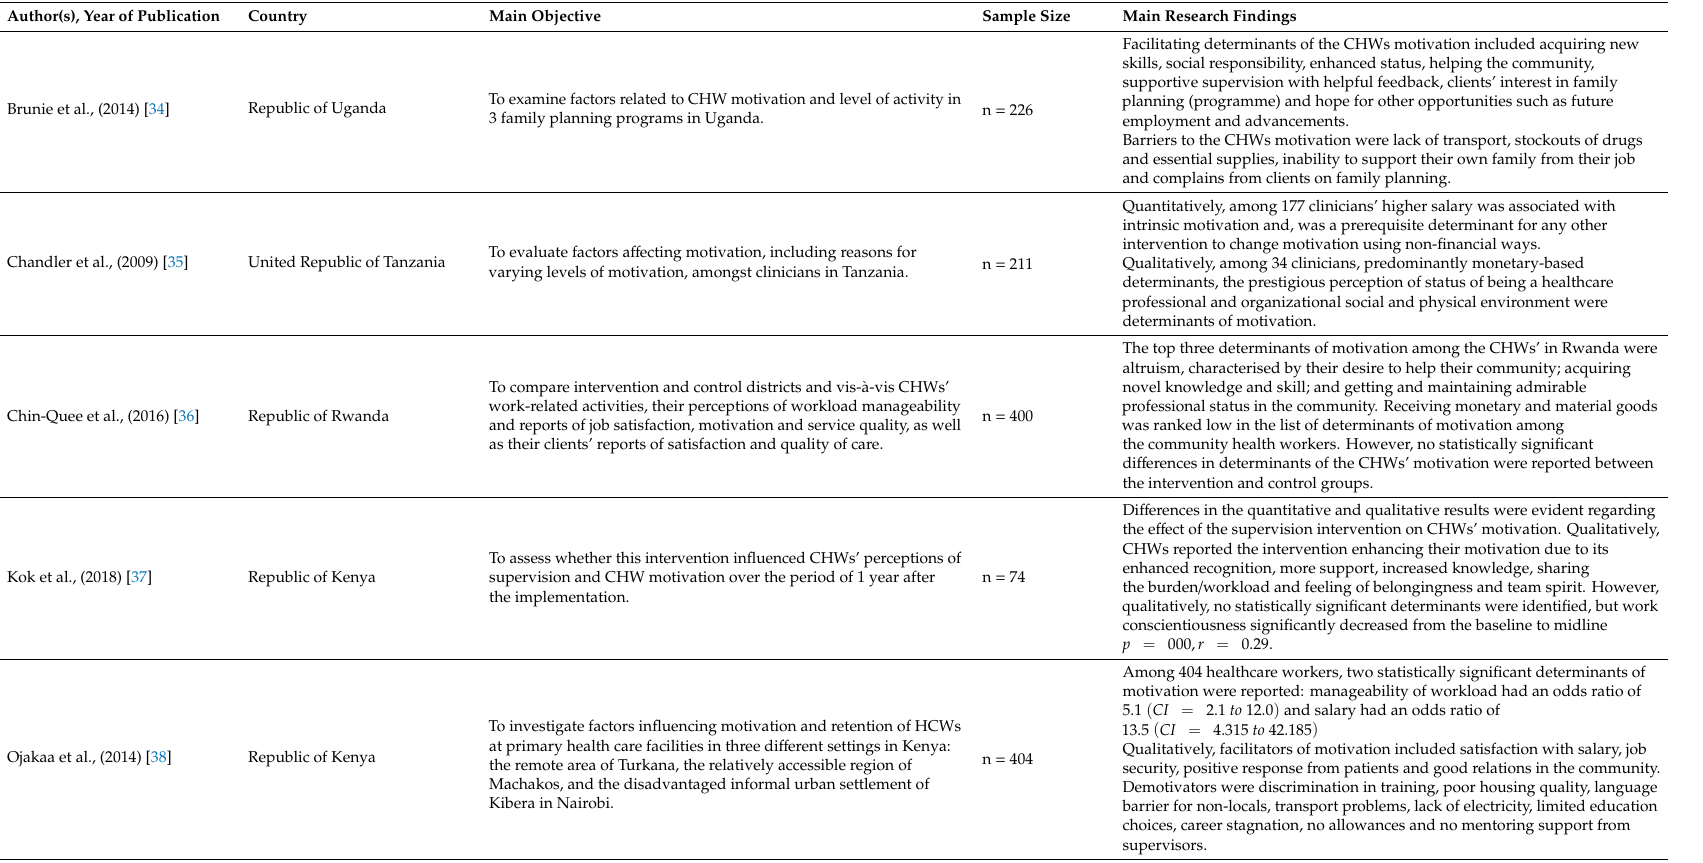
Table 2. Mixed Methods